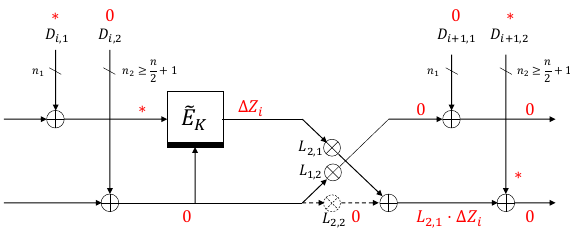
Figure 6: Differential Propagation for Case 2 with L 1 , 1 = 0.